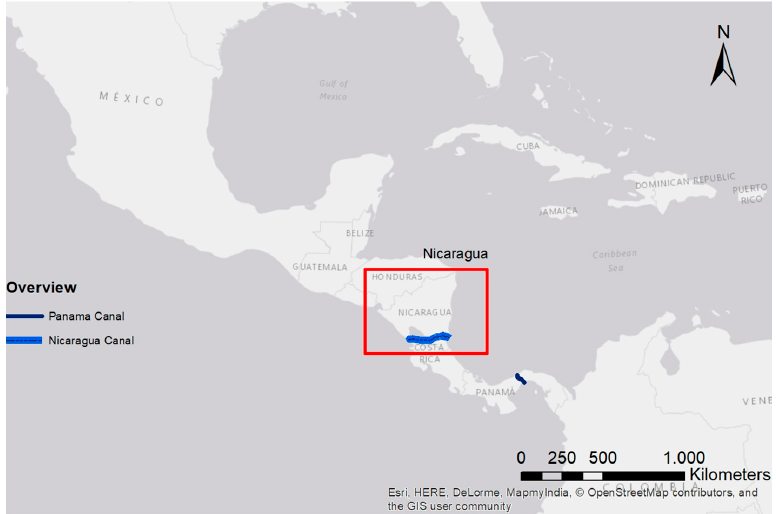
Figure 1. Overview of interoceanic canals of the Americas.